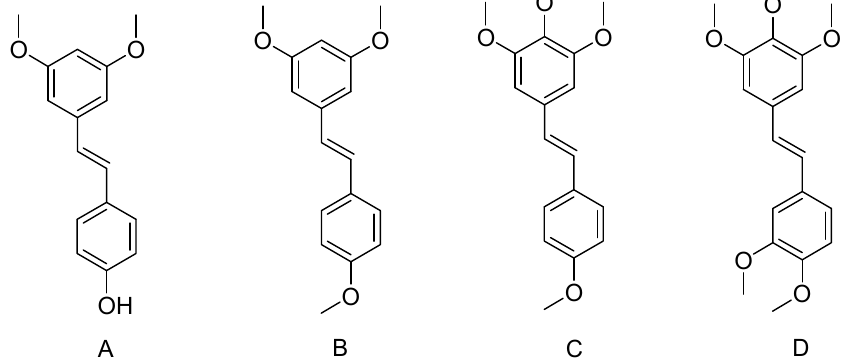
Figure 2. Chemical structures of methoxylated derivatives of resveratrol. ( A ) Pterostilbene; ( B ) Chemical structures of methoxylated derivatives of Trimethoxystilbene; ( C ) Tetramethoxystilbene; ( D ) Pentamethoxystilbene.